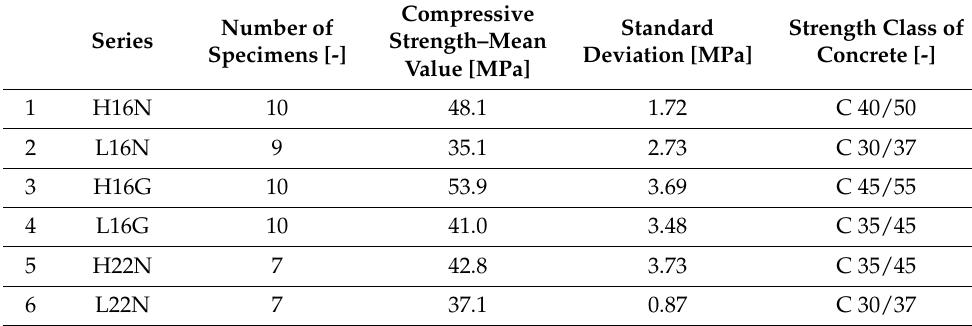
Table 3. Compressive strength of concrete and strength class of concrete for all